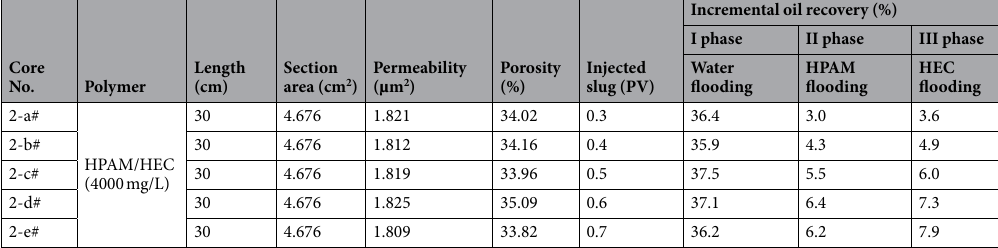
Table 2. The results of HPAM and HEC flooding after water flooding (injection rate: 0.5 mL/min).